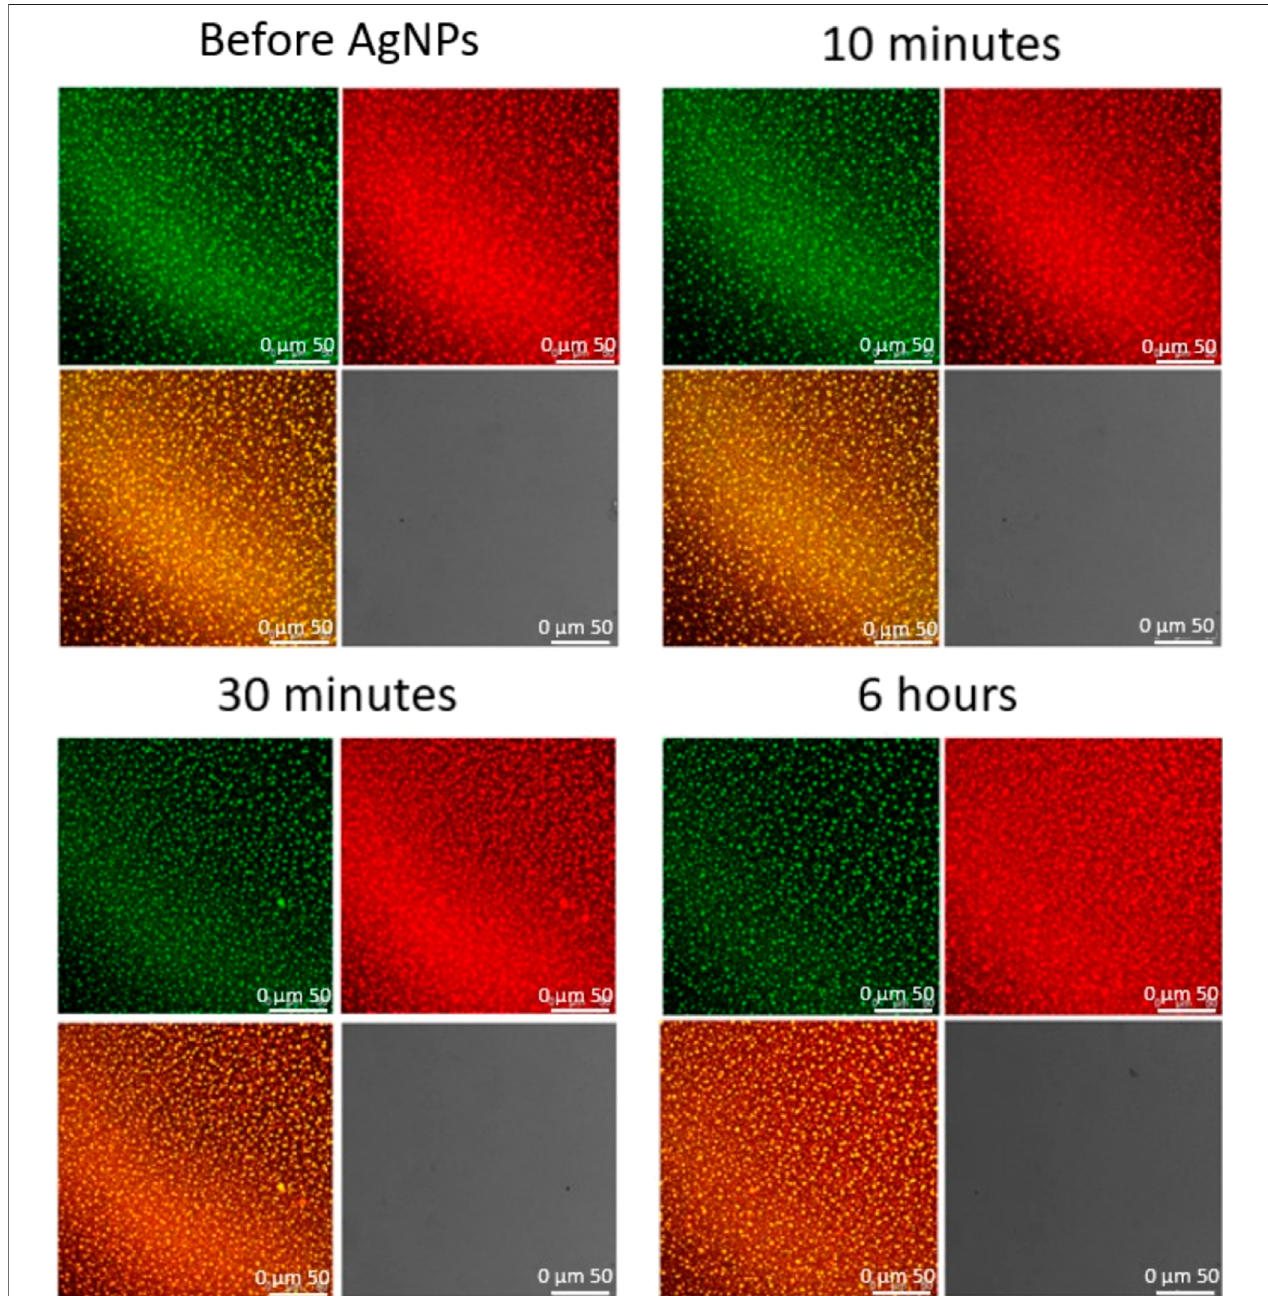
FIGURE7| Representative2DConfocalMicroscopyimagesoftheinteractionofAgNPs0.83 nMwiththe fi lmofcubosomesdepositedontheDOPC/DOTAPSLB. Images collected at different incubation times (before and after 10 min, 30 min, and 6 h from AuNPs injection).